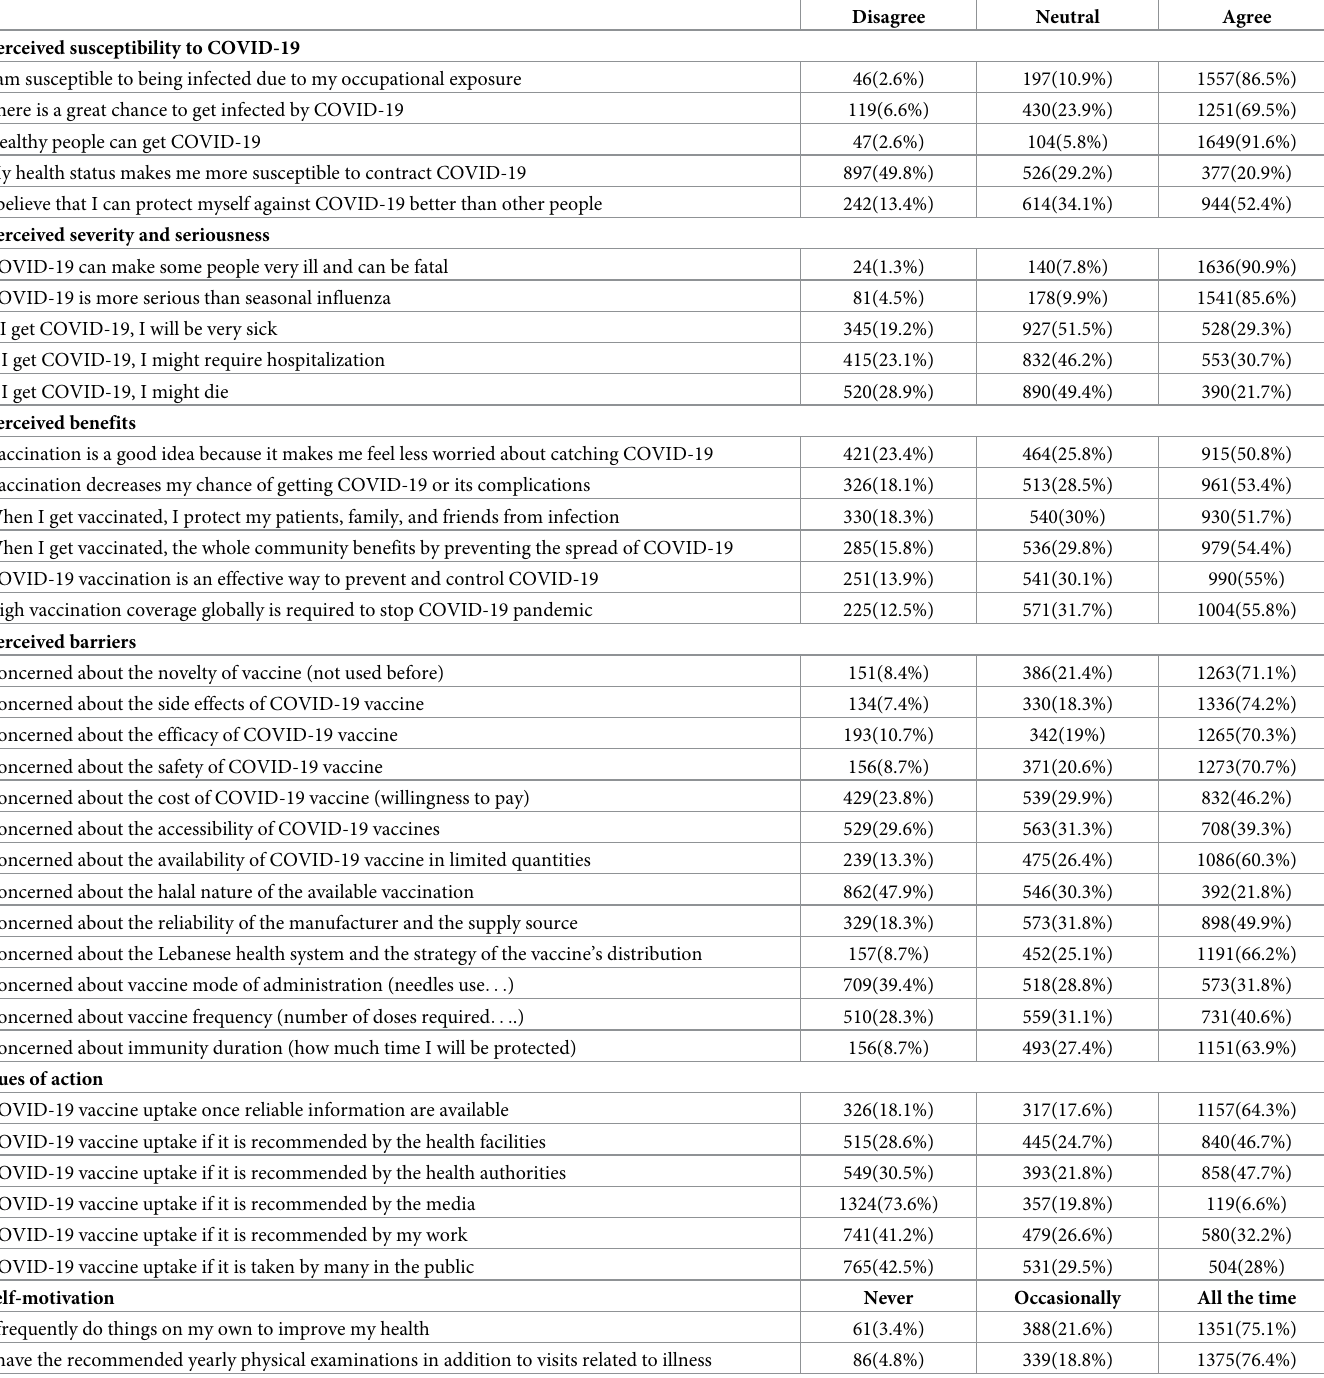
Table 2. HBM items: Perceived susceptibility to COVID-19, perceived severity and seriousness, perceived benefits, perceived barriers, cues of action, and health